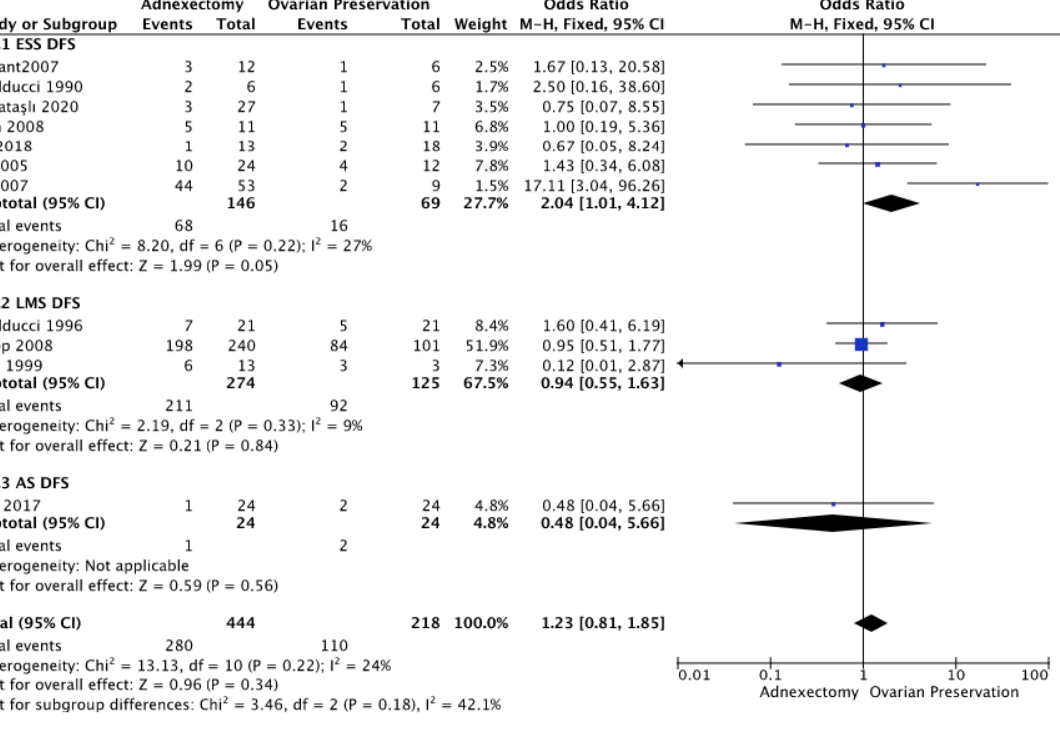
Figure 3. Disease-Free Survival Forrest Plot [6–14,18].